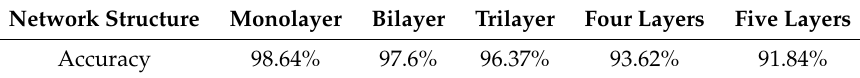
Table 3. Effects of layer number on the performance of